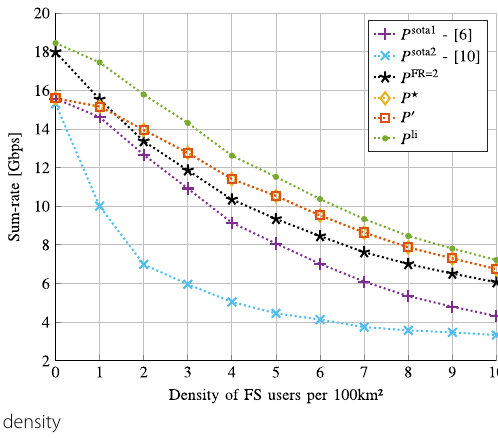
Fig. 2 Sum-rate vs. FS